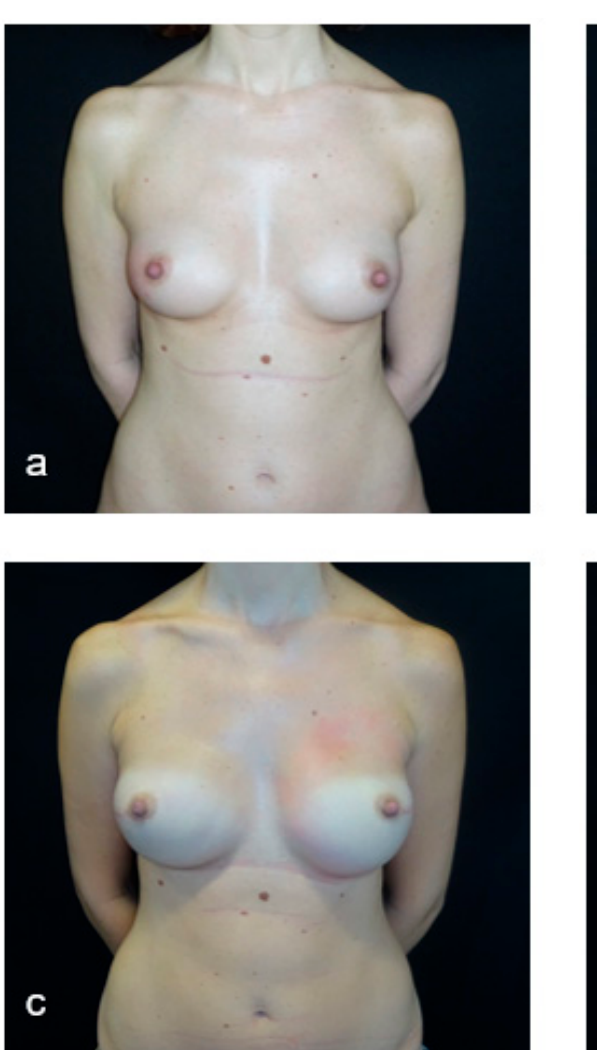
Figure 1. A case of nipple-sparing mastectomy and direct-to-implant prepectoral reconstruction without acellular dermal matrix. ( a , b ) Preoperative pictures of a 43-year-old right-breast cancer patient for whom right nipple-sparing mastectomy and direct-to-implant prepectoral reconstruction without acellular dermal matrix were planned. ( c , d ) Six-month postop- erative pictures after right nipple-sparing mastectomy through a radial lateral incision (mastectomy specimen 190 g) and prepectoral reconstruction using a definitive anatomical implant (Polytech 30746, 295cc) with a micropolyurethane-foam- coated shell surface, placed in the subcutaneous plane.